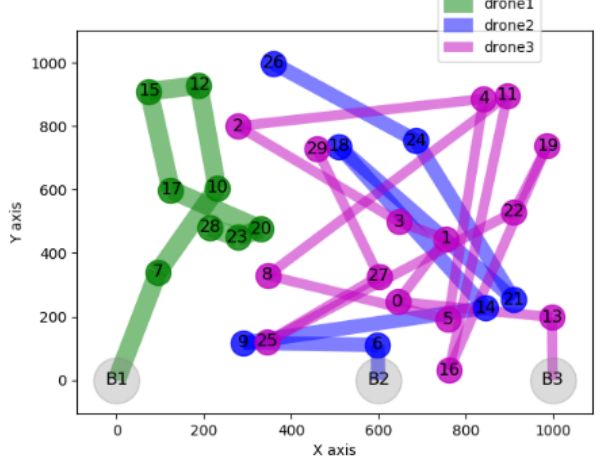
Figure 12. Path details (waiting = ∞